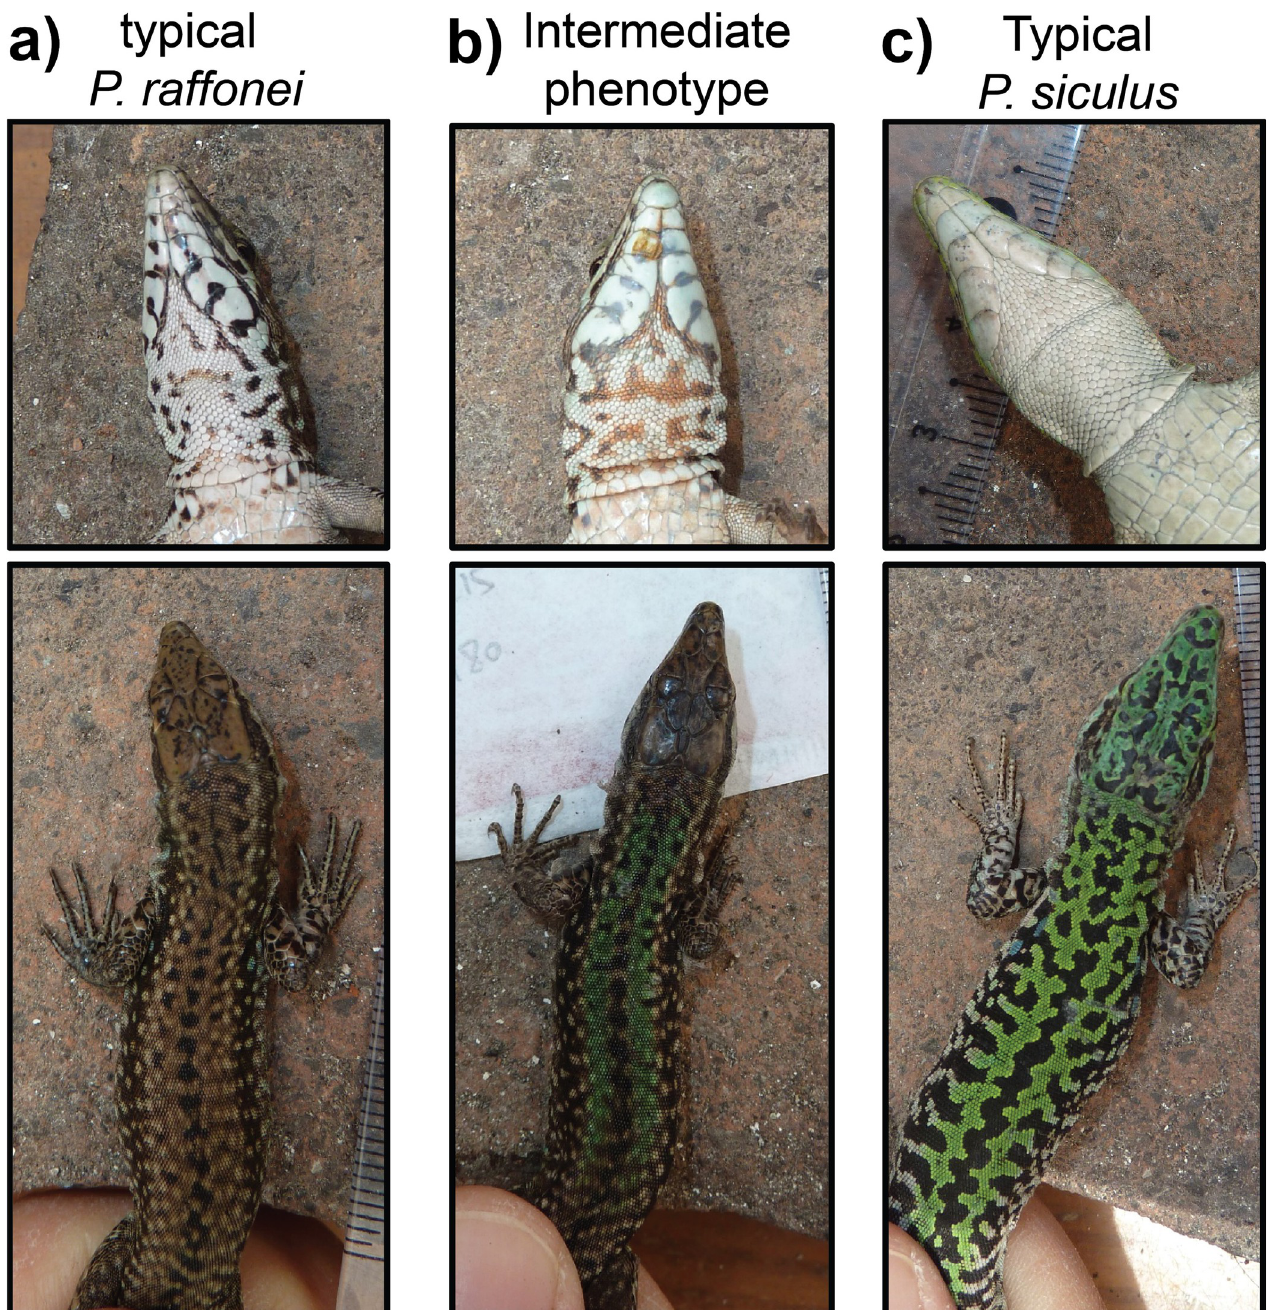
Fig 2. Typical colour patterns of Podarcis raffonei (a) and P . siculus (c), and patterns of individuals with the green phenotype, which is similar to the one of P . siculus